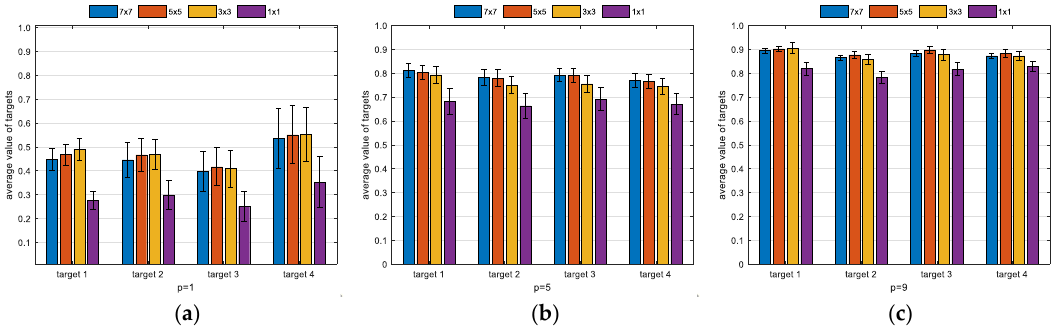
Figure 21. The average values of four target categories in the detection results with different p values.